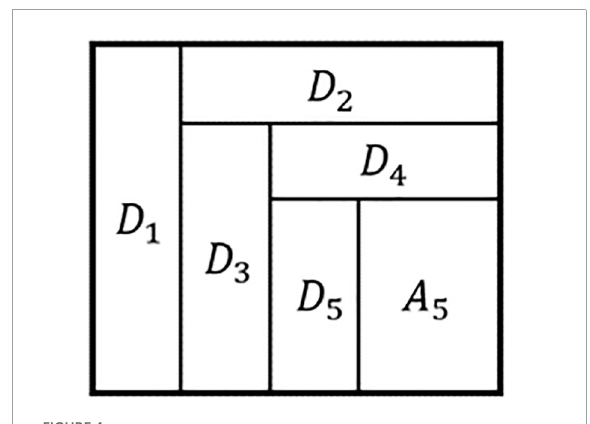
FIGURE4 Schematic diagram of wavelet